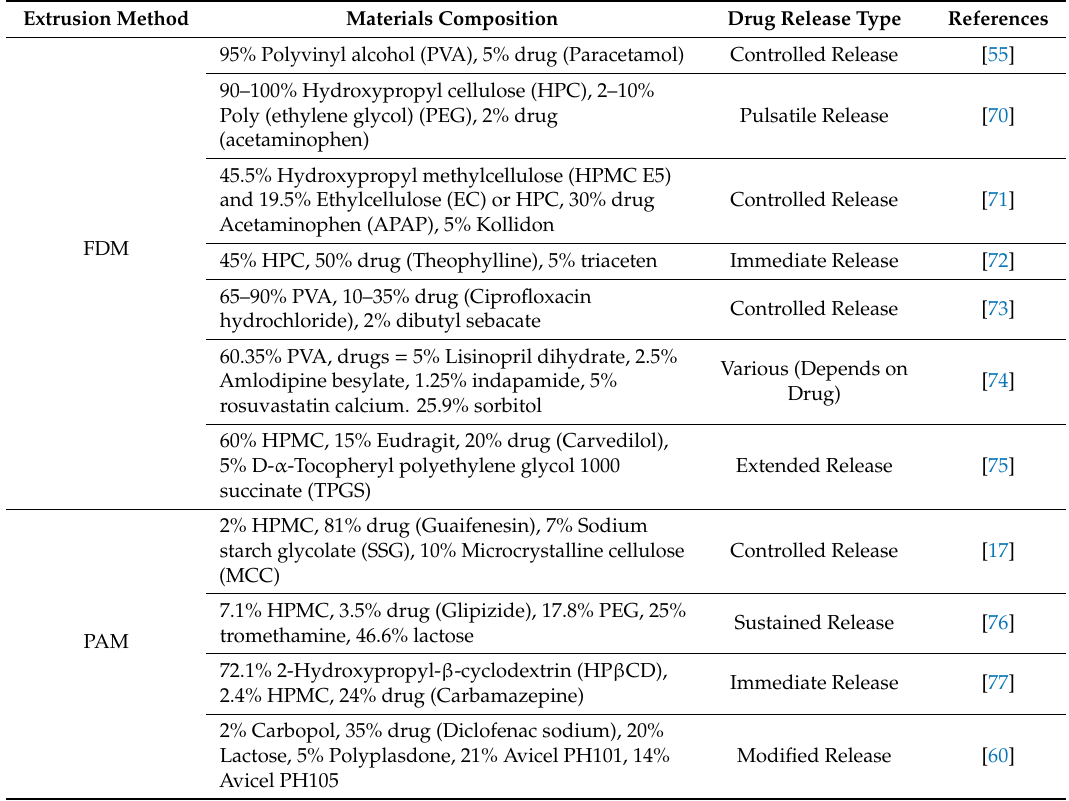
Table 2. Examples of material compositions used in extrusion-based 3D